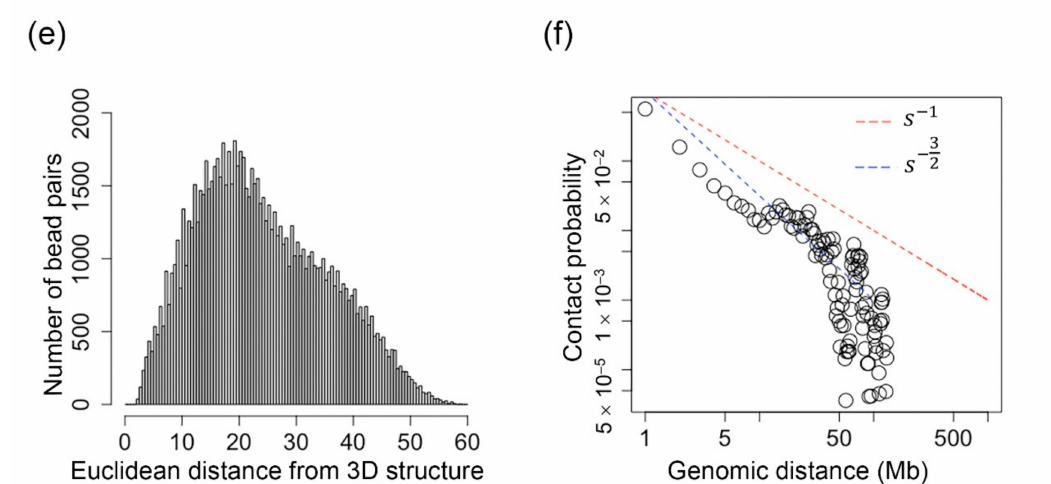
Figure 1. ( a ) The inferred 3D structure of the X-chromosome of a mouse Th1 cell at 50 kb resolution when n in Equation (3) equals 2. ( b ) Each black dot indicates one single-cell Hi-C contact. The darker orange color indicates higher Euclidean distances parsed from the inferred 3D structure, and the white color indicates small Euclidean distances parsed from the inferred 3D structure. ( c ) The distribution of the number of bead pairs over different values of Euclidean distances parsed from the inferred structure when θ i,j = 1. ( d ) The distribution of the number of bead pairs over different values of Euclidean distances parsed from the inferred structure when θ i,j ∈ ( 0.7, 1 ) . ( e ) The distribution of the number of bead pairs over different values of Euclidean distances parsed from the inferred structure when θ i,j ∈ ( 0, 0.7 ] . ( f ) The contact probability of bead pairs over different values of genomic